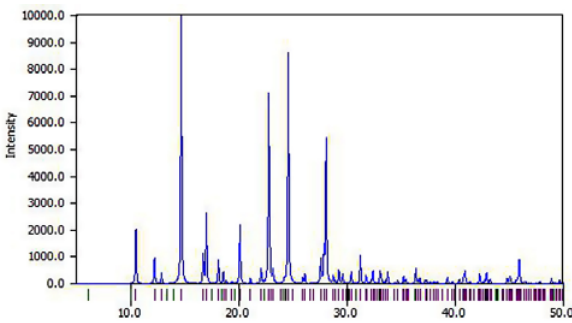
Fig. 15: Simulated XRD pattern of the Predicted polymorph (Str 1)